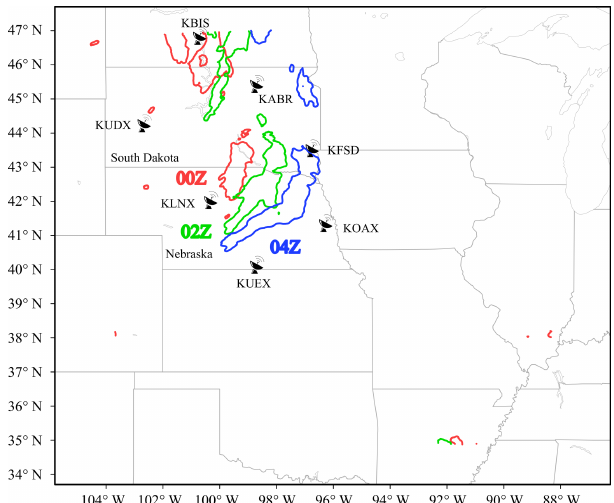
Figure 2. The simulation domain with radar sites marked by radar icons and names. The areas of precipitation greater than 5mmh − 1 are plotted for 00:00Z (red), 02:00Z (green), and 04:00Z (blue) on 2 June